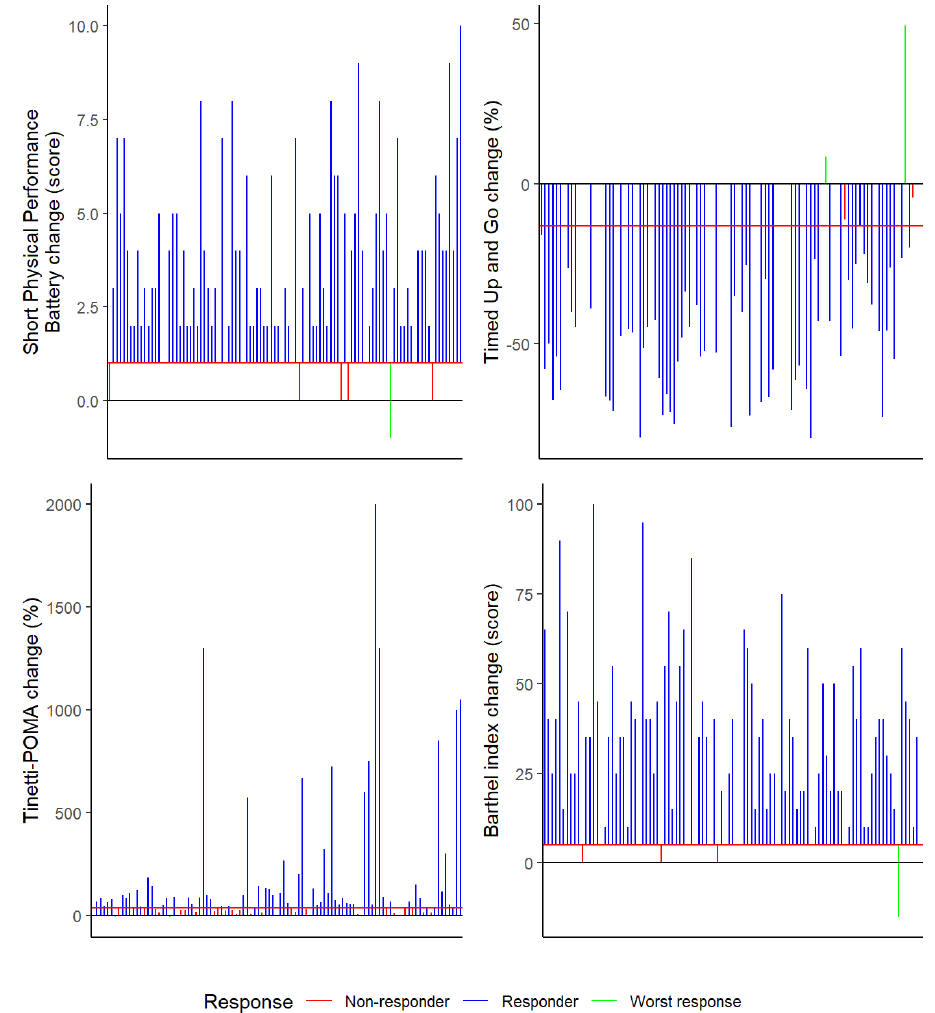
Figure 1. Responders and non-responders rate